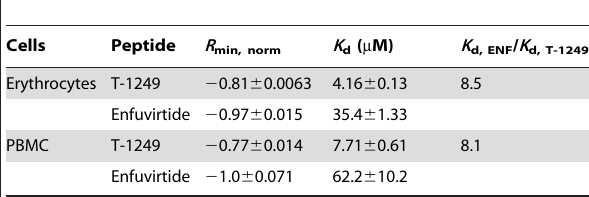
Table 1. Quantification of peptide binding.